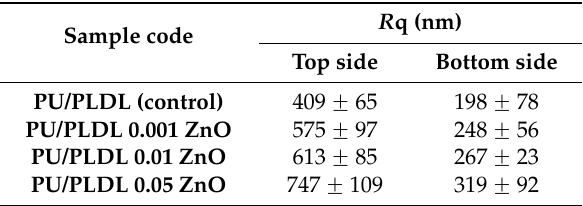
Table 2. Surface roughness values ( R a) of PU/PLDL blend and PU/PLDL/ZnO composite obtained using AFM analysis.